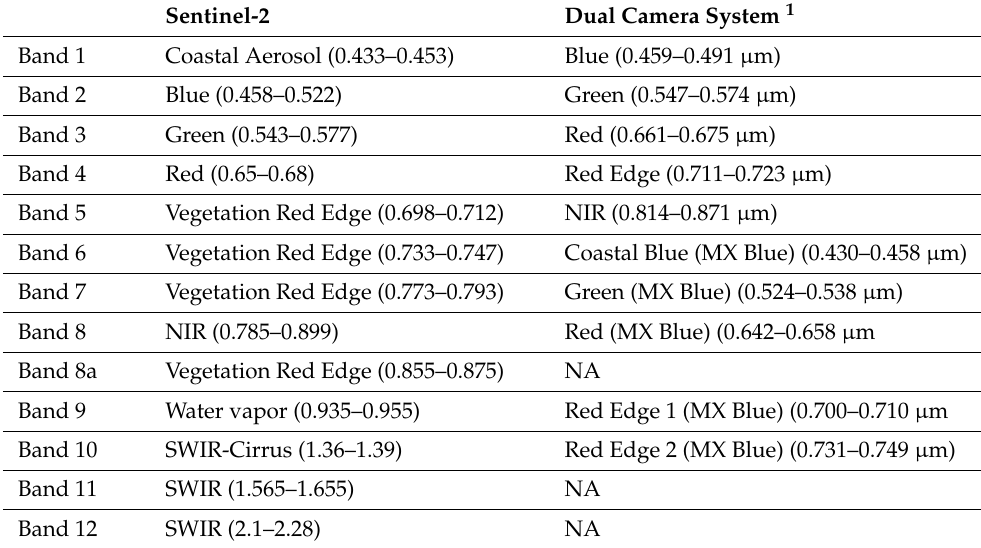
Table 2. Wavelengths for Sentinel-2 and sUAS [32,33] remote sensing. NA refers to the cells where the sensor is not designed to collect the corresponding bandwidth